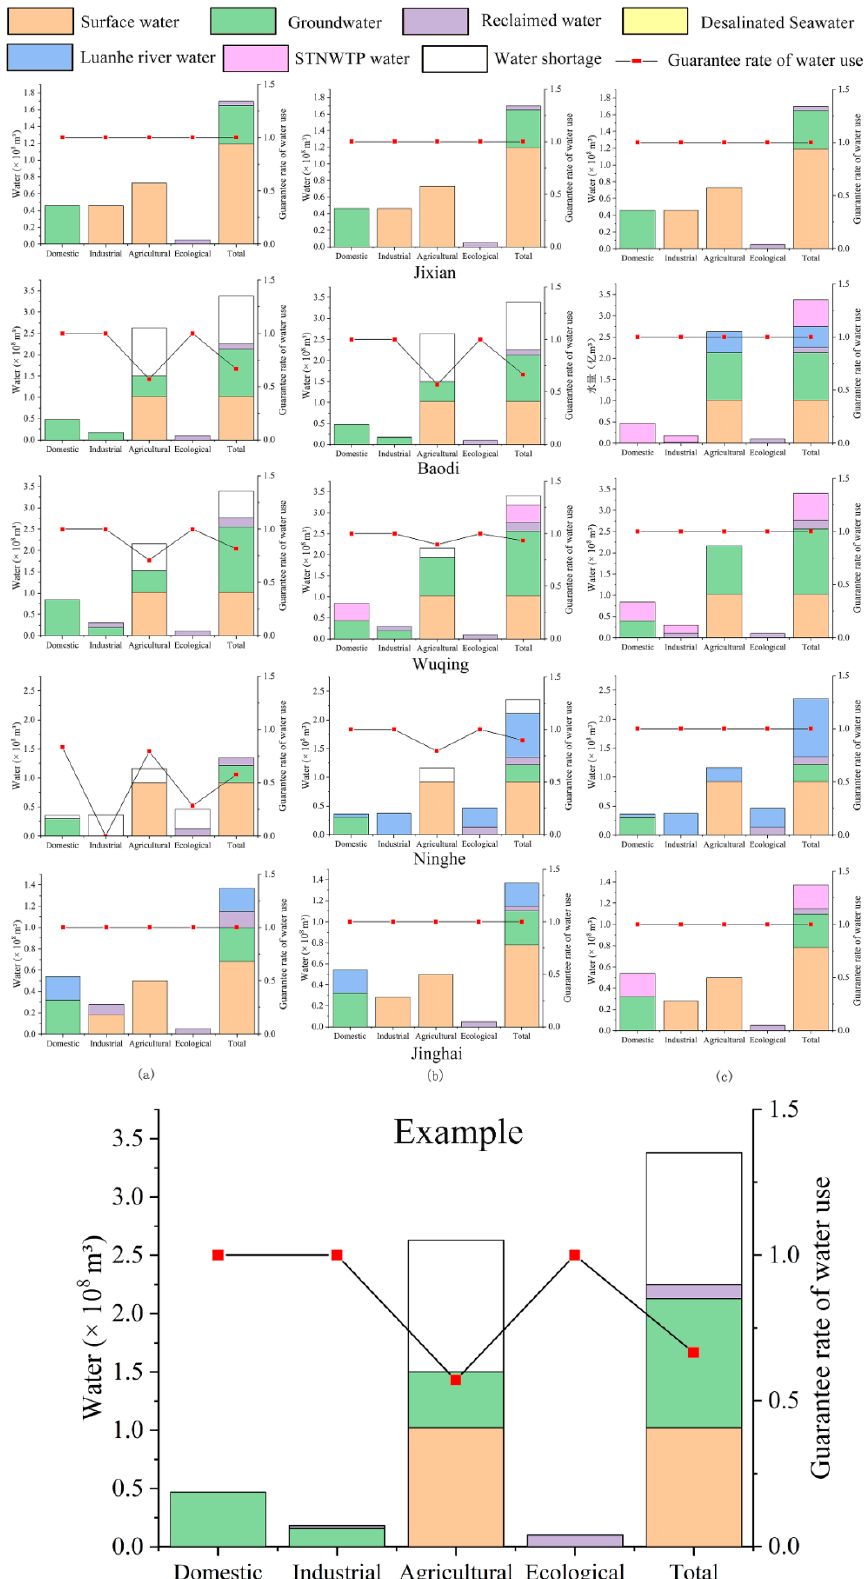
Figure 7. The guarantee rate of water use in suburban areas for: ( a ) (surface water 50% + Luanhe river water 75%); ( b ) (surface water 50% + Luanhe river water 75% + STNWTP water 95%); ( c ) (surface water 50% + Luanhe river water 75% + STNWTP water 75%). All coordinates in the figure are the same and shown in Example.